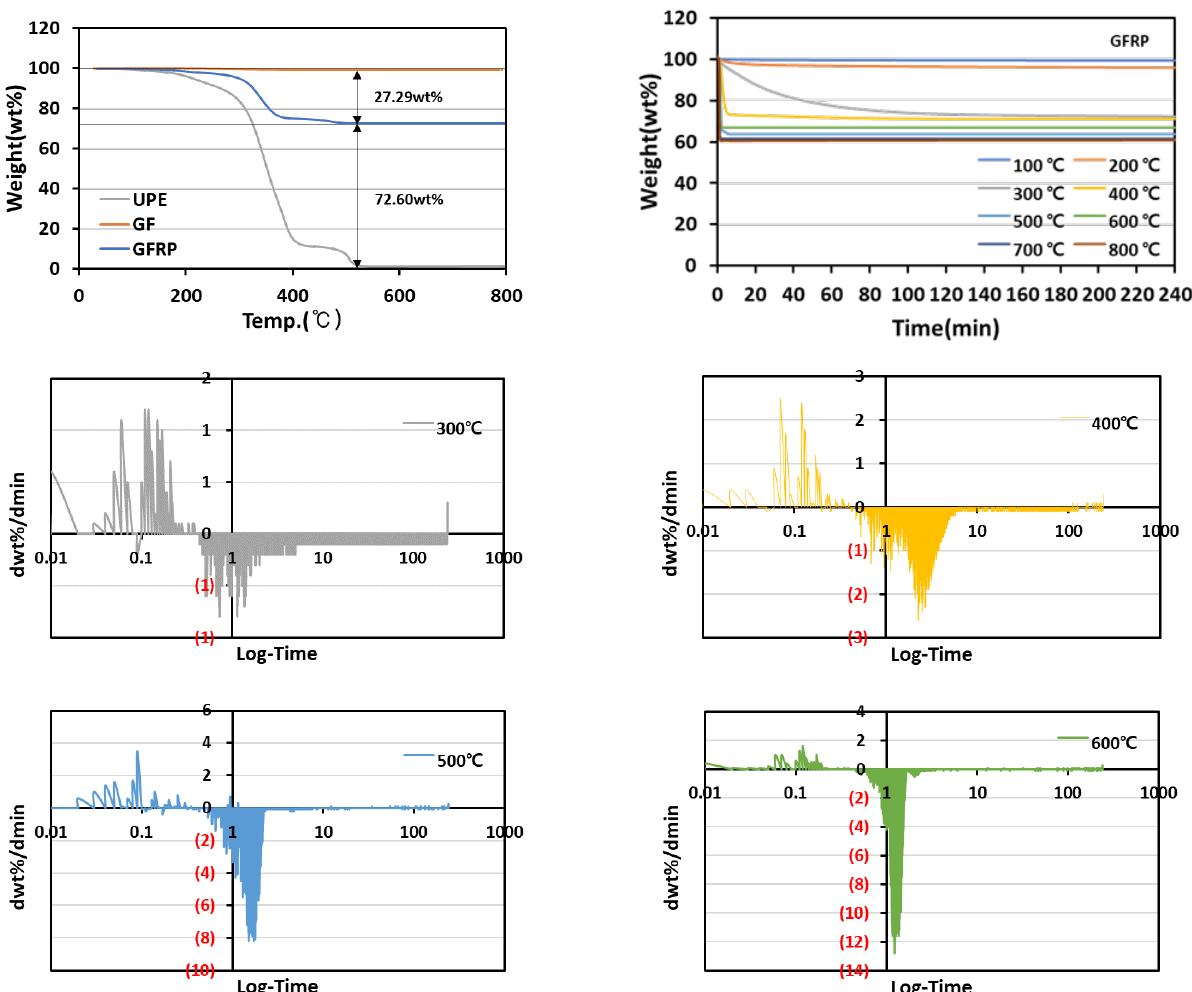
Figure 3. GFRP weight change and heat treatment time according to pyrolysis temperature.